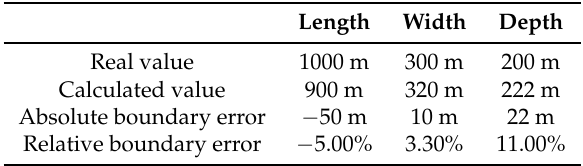
Table 2. Comparison of locating results and the simulated model.